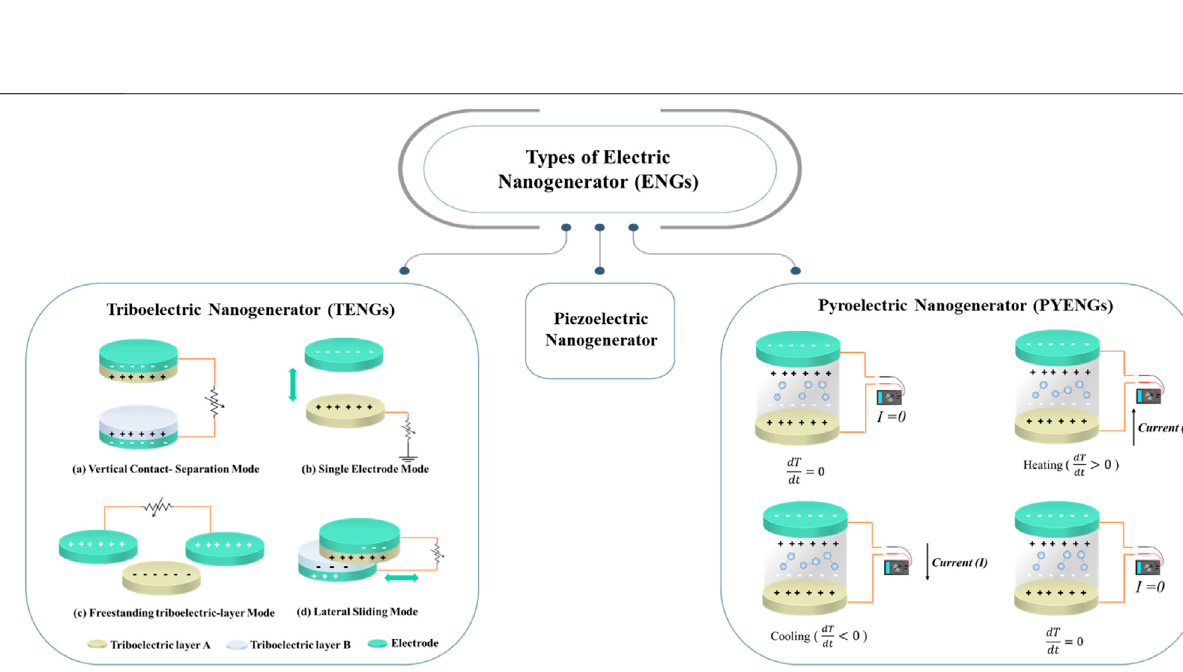
FIGURE 4 | Block diagram illustrates the conversion of various energies to power implanted devices.